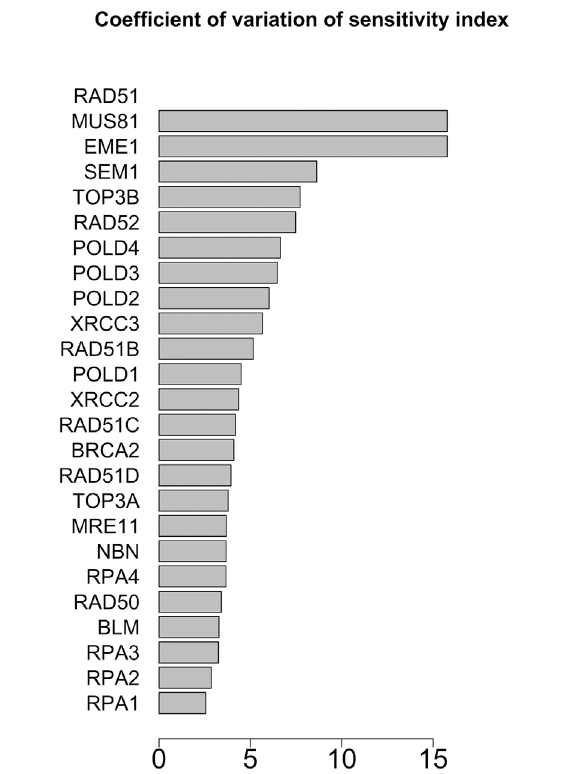
FIGURE8| Coef fi cientofvariationofthesensitivityindexdistributionsfor the proteins in HR network (Orlic-Milacic, 2015). These results refer to simulation in the time interval [18, 20] a.u., and initial values of the proteins randomly sampled in the range [10 – 5 , 10 – 6 ] a. u.